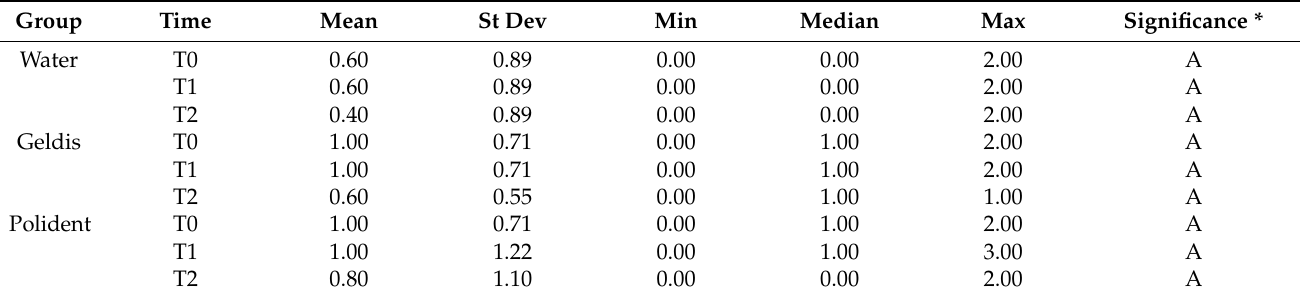
Table 3. Descriptive statistics of Schiff Air Index measurements.